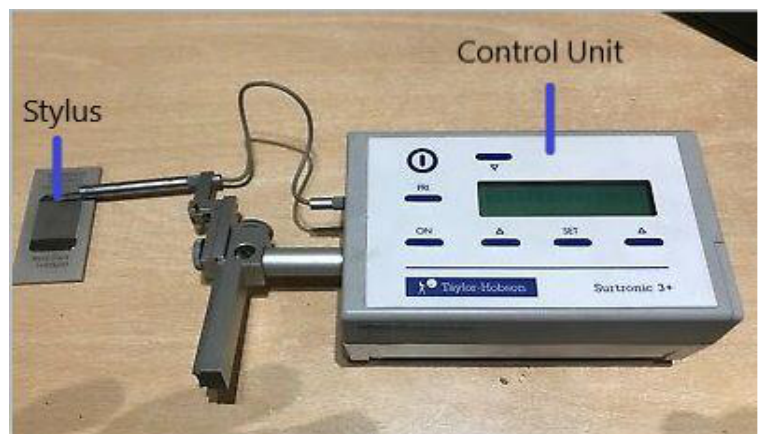
Figure 4: Talyrond Surtronic 3+ surface roughness measurment device